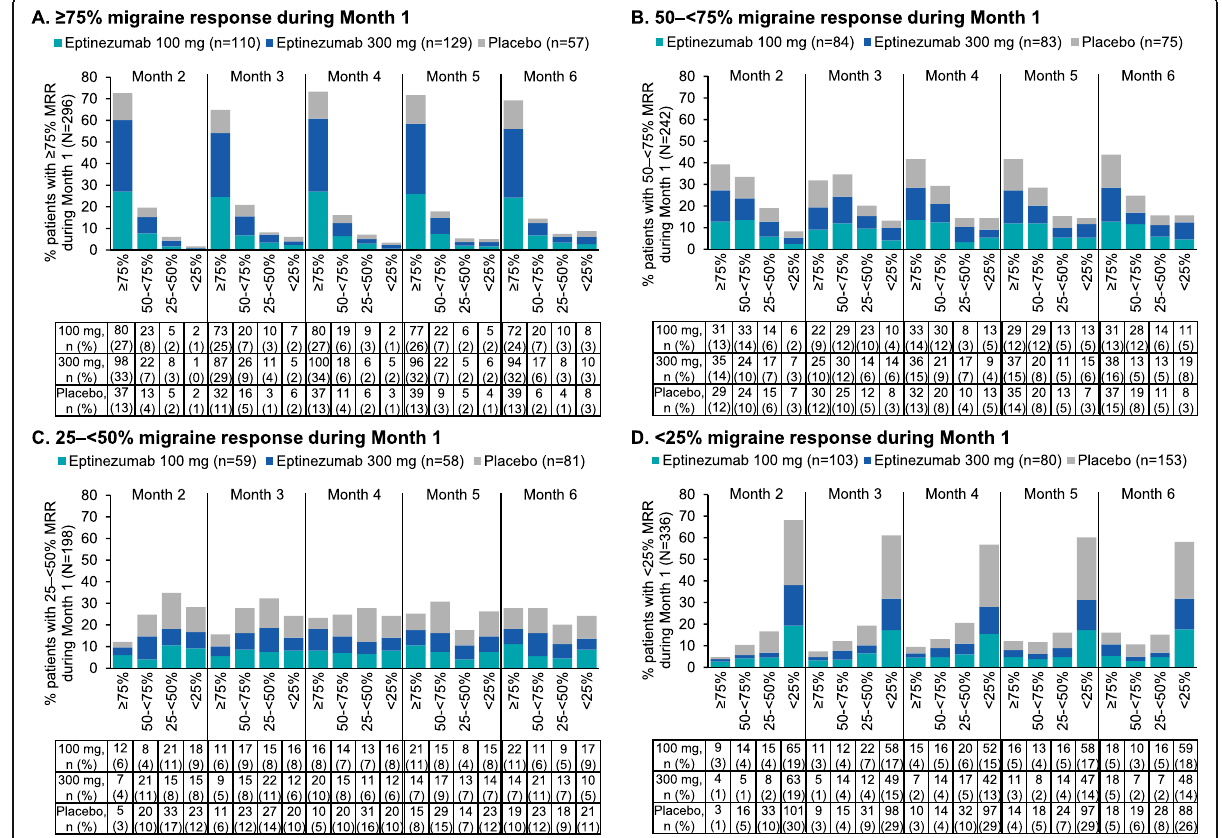
Fig. 2 Monthly response according to Month 1 migraine response a category: ( A ) ≥ 75%, ( B ) 50 – < 75%, ( C ) 25 – < 50%, ( D ) < 25%. a Migraine response was defined as a percentage reduction in monthly migraine days. MRR, migraine responder